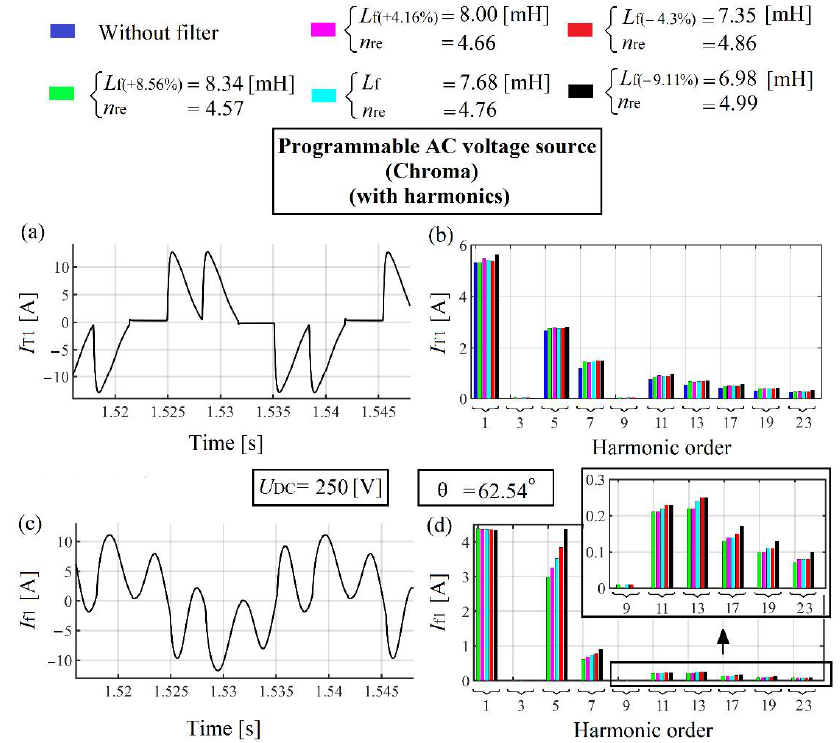
Figure 60. ( a ) Rectifier input current waveform with ( b ) the spectrum, ( c ) filter current waveform with ( d ) the spectrum.